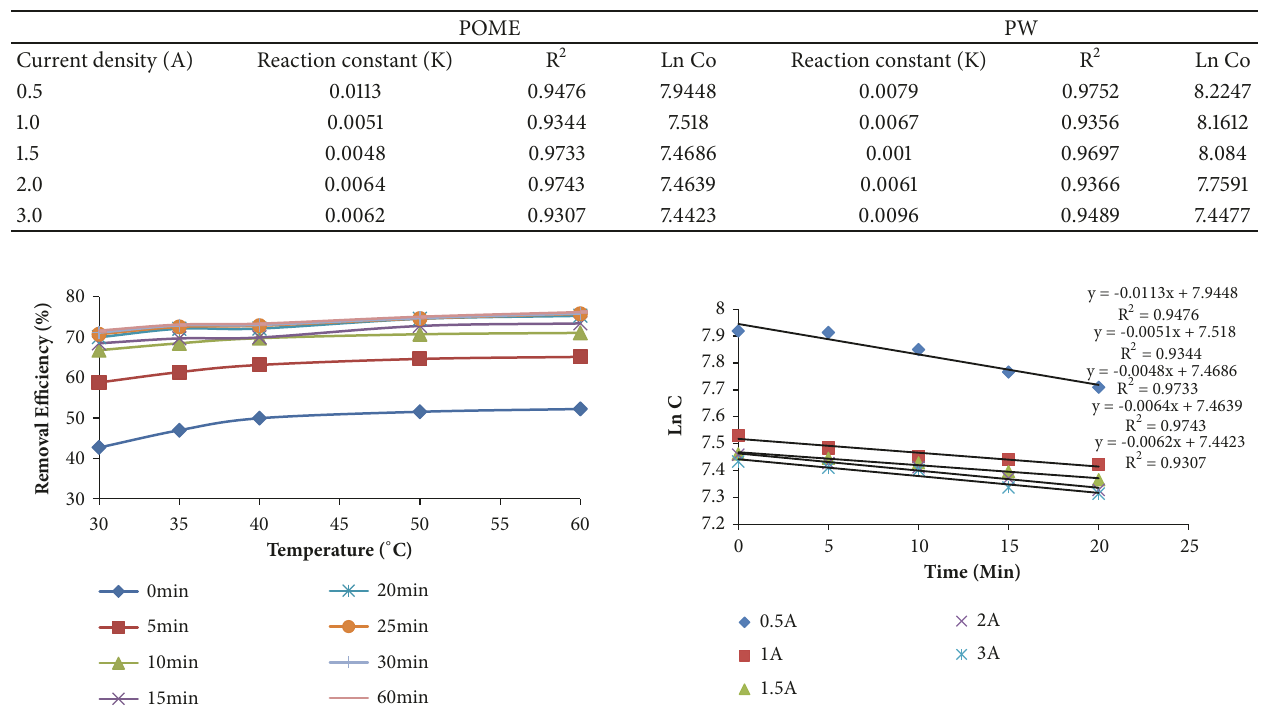
Figure 8: First-order kinetics for POME.